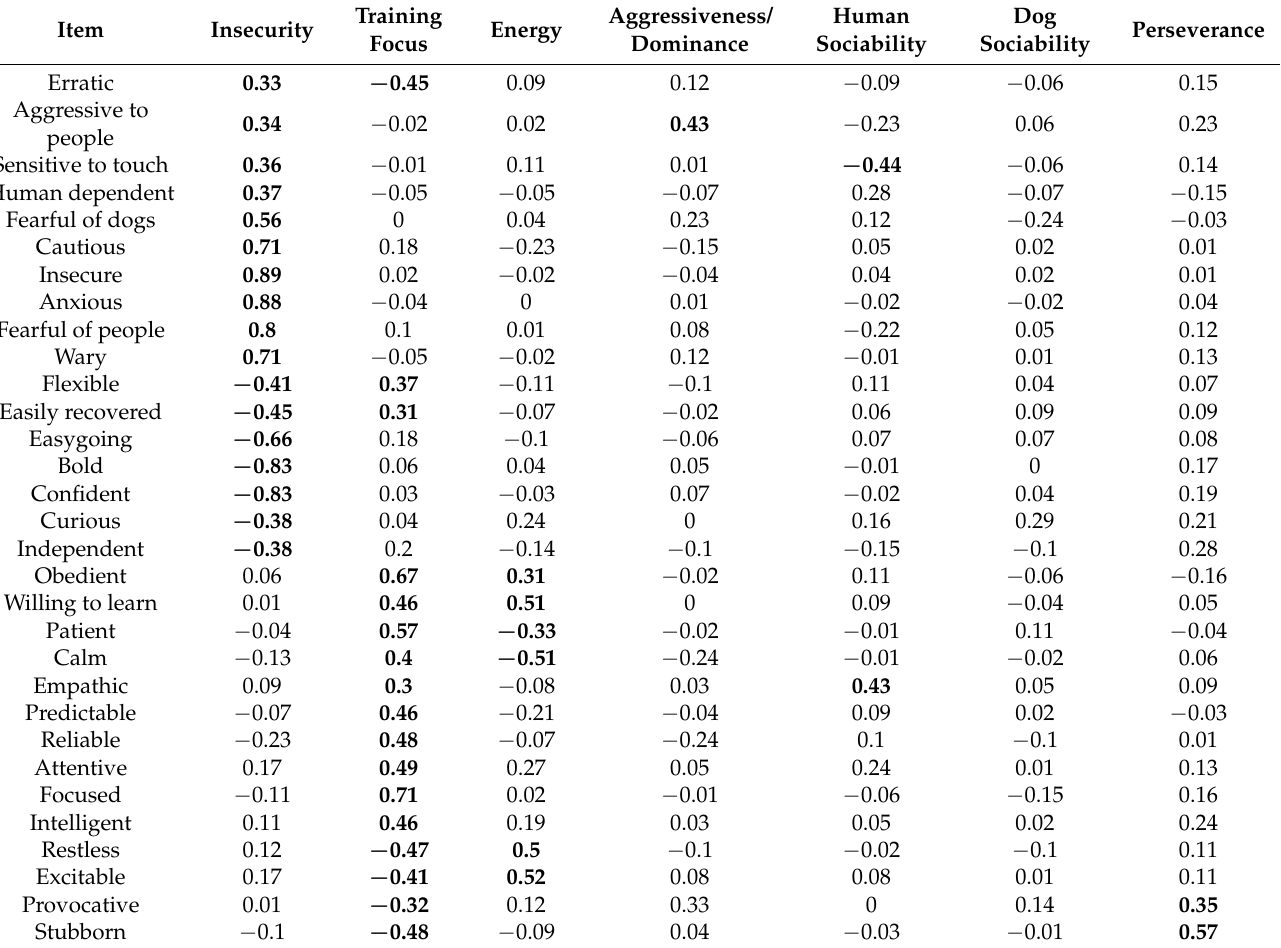
Table 2. Item loadings in the personality